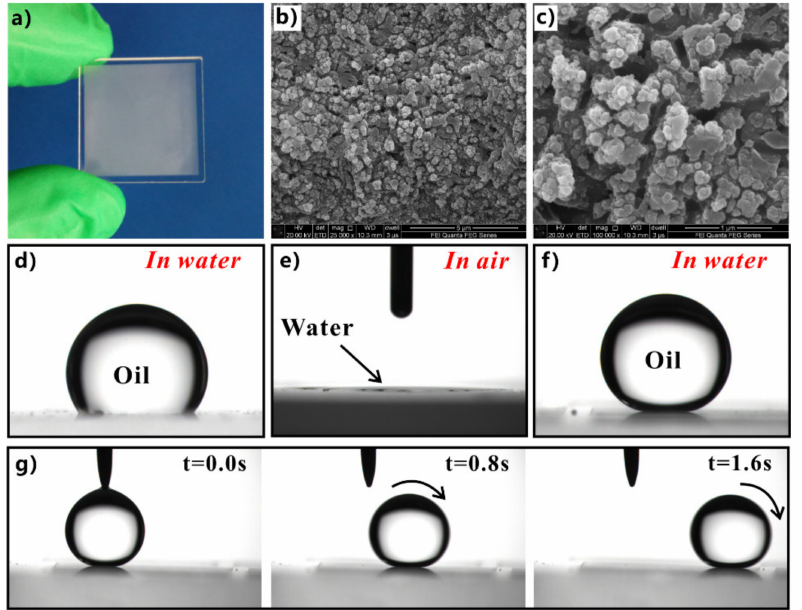
Figure 8. Achievement of underwater superoleophobicity on the silica glass substrate by forming surface microstructure. ( a ) Photo of the structured glass sheet. ( b , c ) Nanostructure on the glass surface. ( d ) A drop of oil on the original flat glass surface underwater. ( e ) Water wetting the structured glass surface in the air. ( f ) Underwater oil droplet on the structured glass surface. ( g ) The rolling process of an oil droplet on the sample surface with a small tilted angle in the water. Reprinted with permission from ref. [201]. Copyright 2015, The Royal Society of